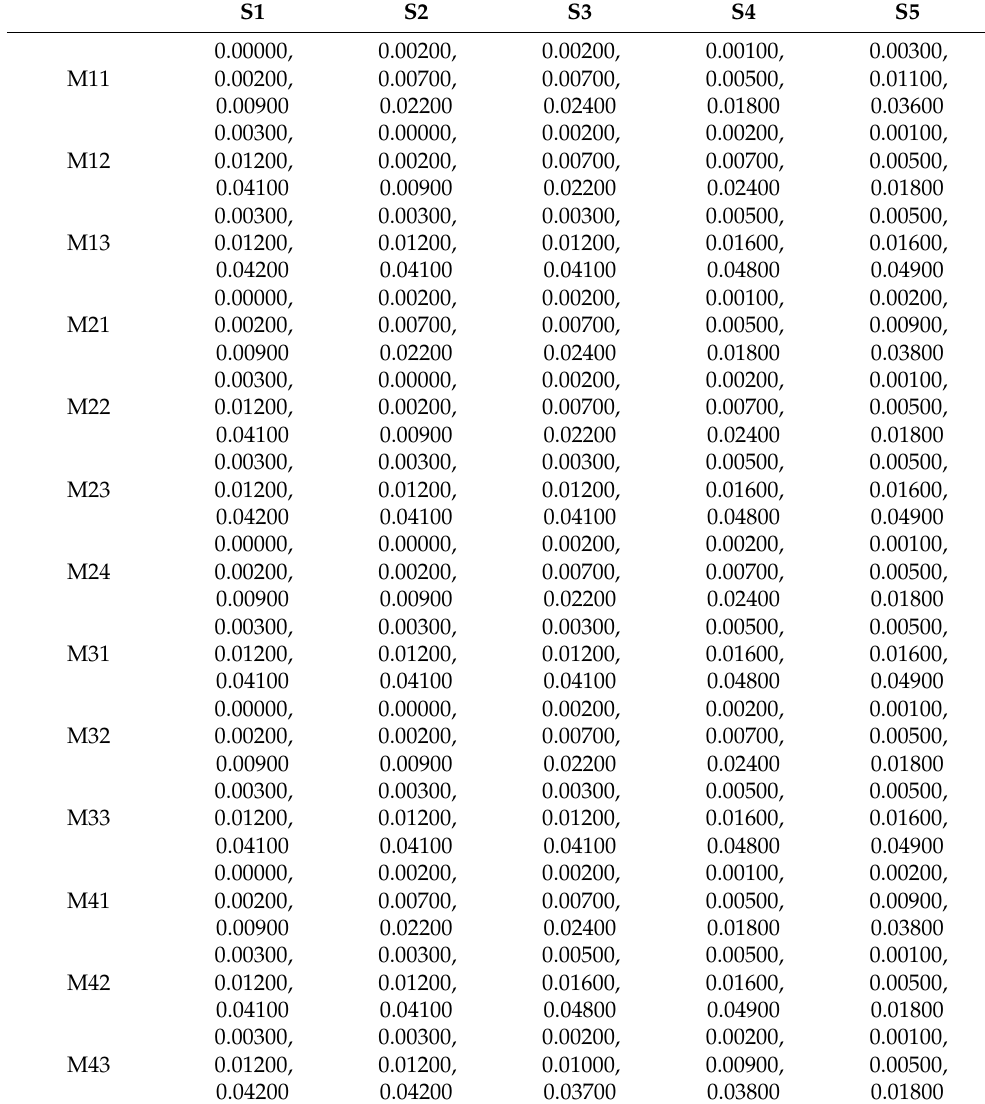
Table 17. Fuzzy decision matrix with weighted normalization.